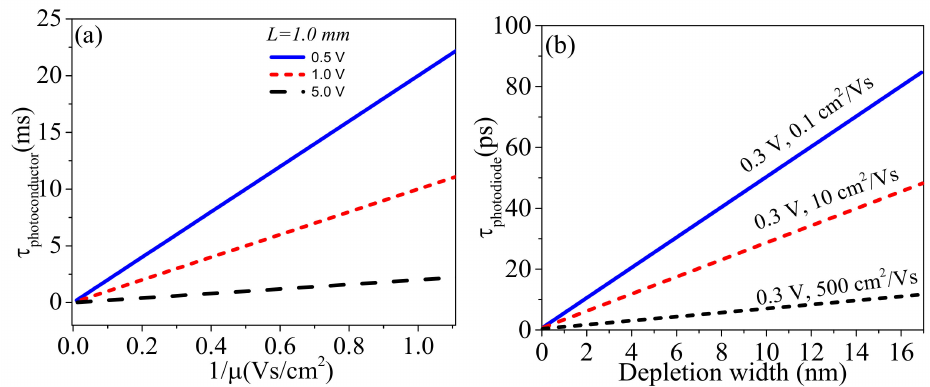
Figure 1. ( a ) Dependence of transit time on inverse of mobility for a photoconductor at constant electrode spacing L = 1.00 mm and di ff erent bias, ( b ) Dependence of transit time on depletion width for a photodiode at constant bias and di ff erent mobilities. The transit time strongly depends on mobility and bias for a photoconductor where as it strongly depends on the width of the depletion region and mobility for a photodiode. ( a , b ) are reproduced with permission from reference